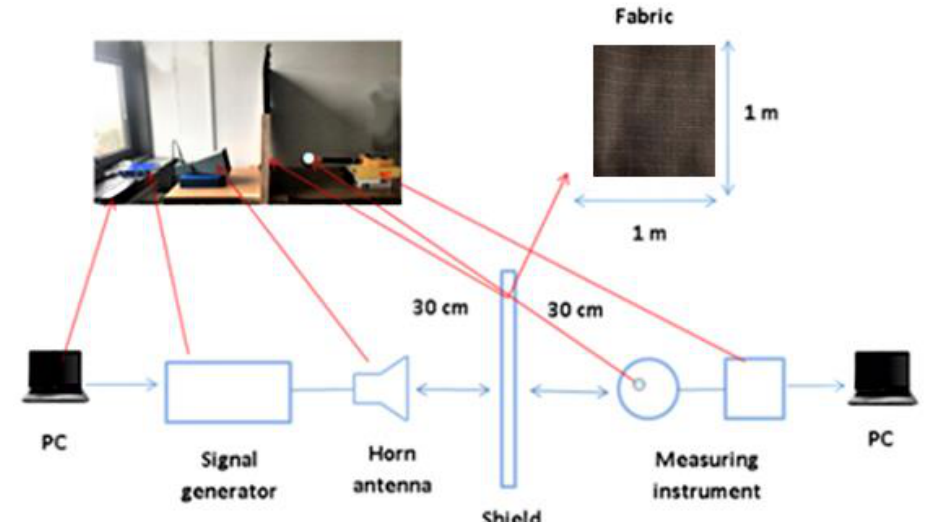
Figure 2. Schematic view of measuring set-up created by authors .